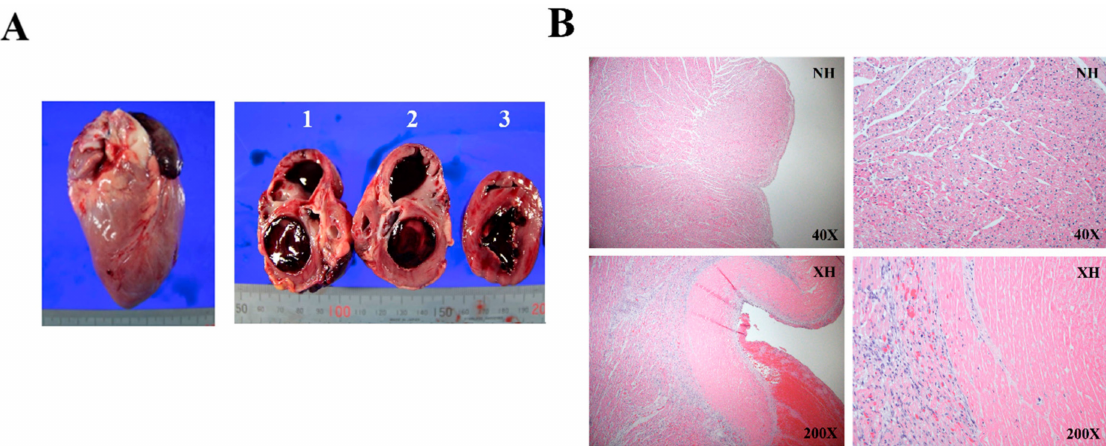
Figure 1. Gross and microscopic findings of the rejected porcine heart (XH). ( A ) Representative images showing anterior ( left ) and interior views ( right ) of XH. Interior views include sagittal plane (1 and 2) and transverse plane (3) of the XH heart. ( B ) Photomicrographs showing endomyocardial infarction and interstitial fibrosis in XH to compare with the normal histological appearance in the control porcine